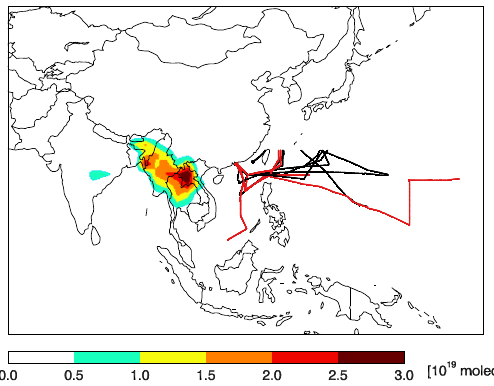
Fig. 3. Monthly mean biomass-burning emissions of CO from East and South Asia for March 2001. Monthly mean emission totals were from the inventory developed by Streets et al. (2003) and temporally distributed based on the daily burned area from GFED4 (Giglio et al., 2013). Also shown are the locations of the BC measurements over the northwestern Pacific from the Trace-P aircraft campaign which we used for model evaluation in Sect. 5 (black lines: DC-8; red lines: